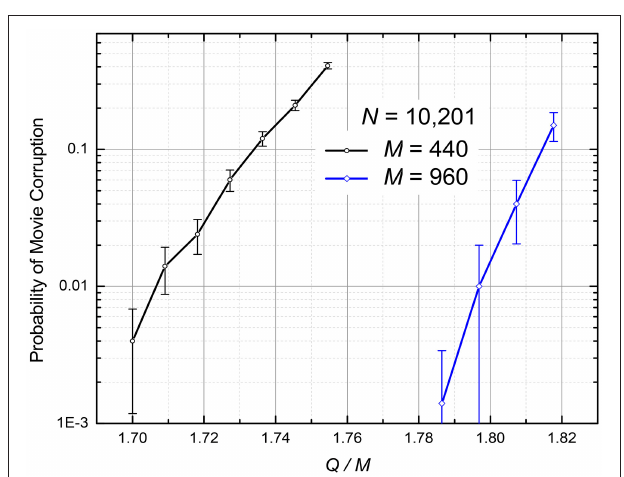
FIGURE 6 | The numerically calculated probability of the retrieved movie’s corruption at the quadratic programming (The curves are only guides for the eye). The error bars represent standard deviation of the mean based on 500 simulations for M 440 and 100 simulations for M = =